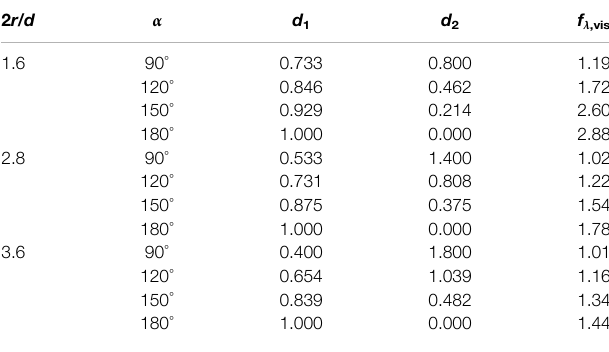
TABLE 1 | Dimension parameters and viscous correction coef fi cients of conical bottom cylindrical